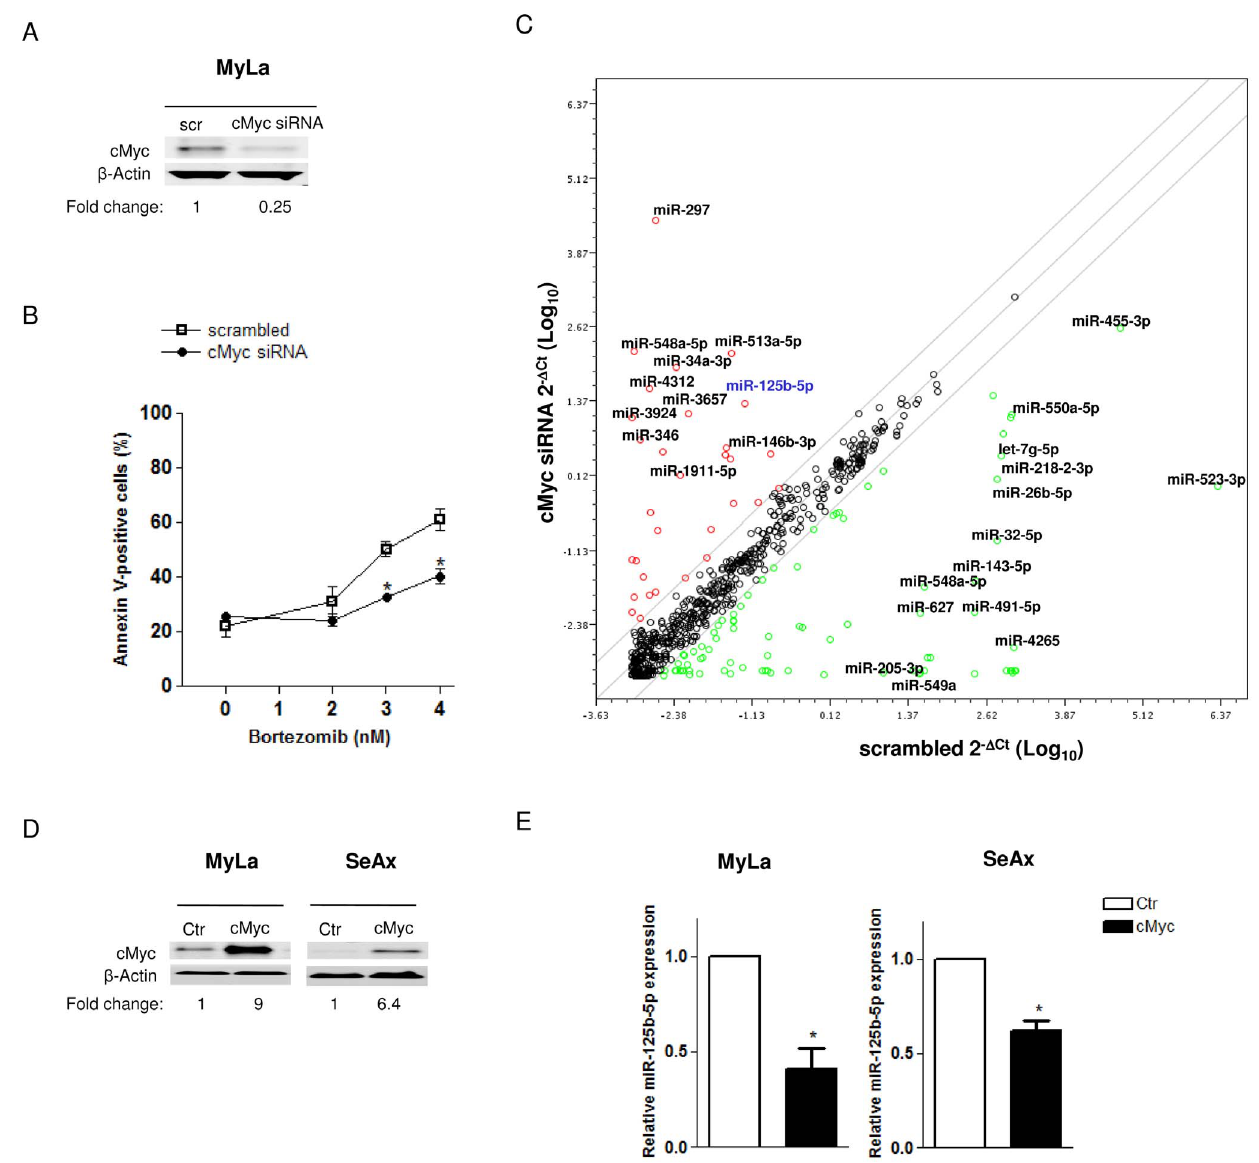
Figure 1. Identification of miRNAs regulated by cMyc in CTCL. (A) Efficient downregulation of cMyc protein after 24h cMyc silencing in MyLa cells. cMyc protein bands were normalized to b -actin band intensities and relative protein expression levels are reported below the corresponding Western blot bands. (B) Effect of cMyc silencing on the apoptosis induced by 48h treatment with bortezomib in MyLa cells. Apoptosis was measured by annexin V and propidium iodide staining for flow cytometry. Bar graph shows the percentage of annexin V-positive cells in the total cell population. Data are presented as mean 6 SD (* P , 0.05). (C) Scatter plot of the human miRNome miScript miRNA PCR Array profile depicting the changes in miRNA expressions after cMyc silencing in MyLa cells. The graph was obtained by plotting the normalized log 10 miRNA expression (2 2 D ct ) in cMyc-knockdonwn MyLa cells (y-axis) divided by the one in the control sample (x-axis). miRNAs were sorted using a $ 4 fold-regulation cutoff and miRNAs upregulated and downregulated are showed with red and green dots, respectively. (D) Overexpression of cMyc protein in CTCL cells (MyLa and SeAx) transfected with cMyc expression plasmid (cMyc) compared to the ones transfected with the control vector (Ctr). cMyc protein levels are reported as in Figure 1A. (E) qRT-PCR showing the miR-125b-5p downregulation after cMyc accumulation. Data are presented as mean 6 SD (* P , 0.05). doi:10.1371/journal.pone.0059390.g001 miRNA of interest (Applied Biosystems). Subsequently, the cDNA template was diluted 1:15 and the quantitative RT-PCR reaction was carried out as described above for gene expression analysis. miR-191 was used as a reference for the normalization of RT- PCR data (Applied Biosystems).